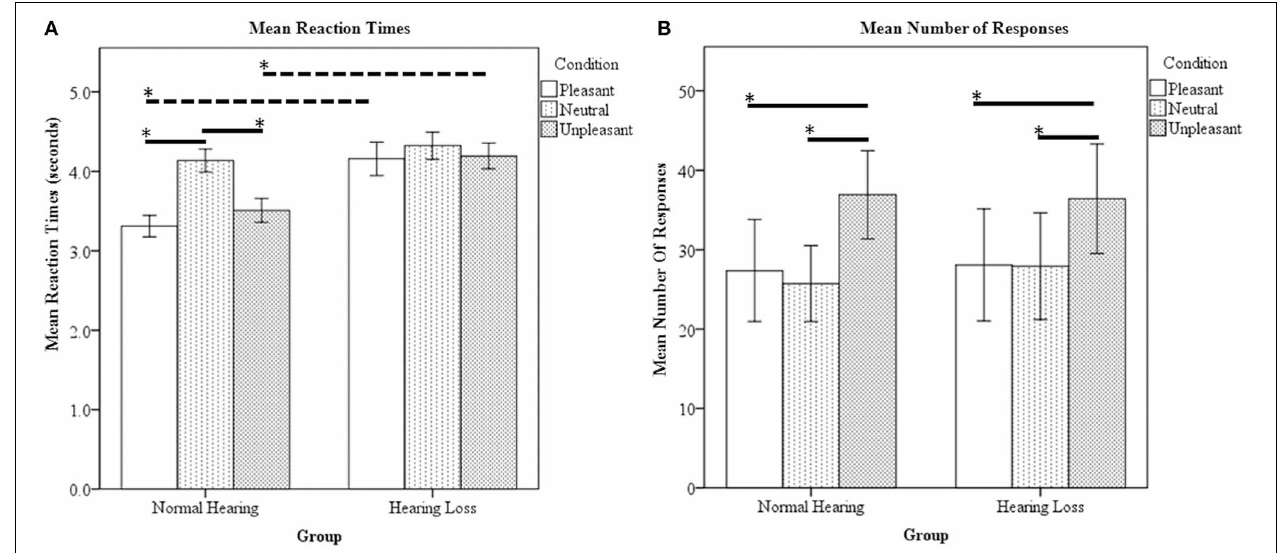
FIGURE 1 | Affective sound categorization task behavioral results. (A) Mean reaction time data. For within group comparison, the HL group did not statistically differ between the P, N, and U reaction times. However, the NH group responded significantly slower to the N sounds compared to the P